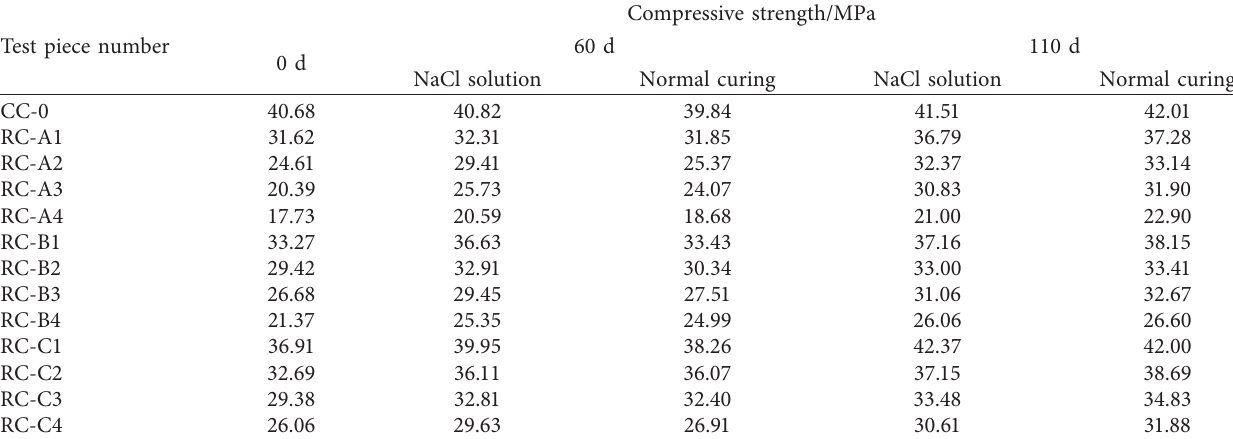
Table 3: Compressive strength of rubber concrete immersed in different solutions for different